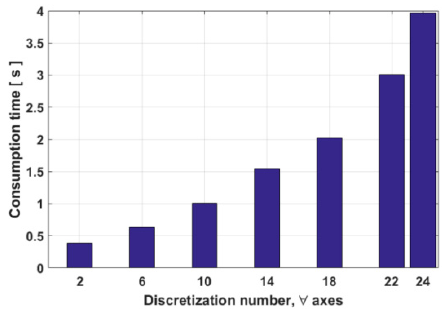
Figure 5. Consumption time for the 2-D generic magnetic equivalent circuit (MEC) according to k (viz., the discretization number in massive conductive parts).